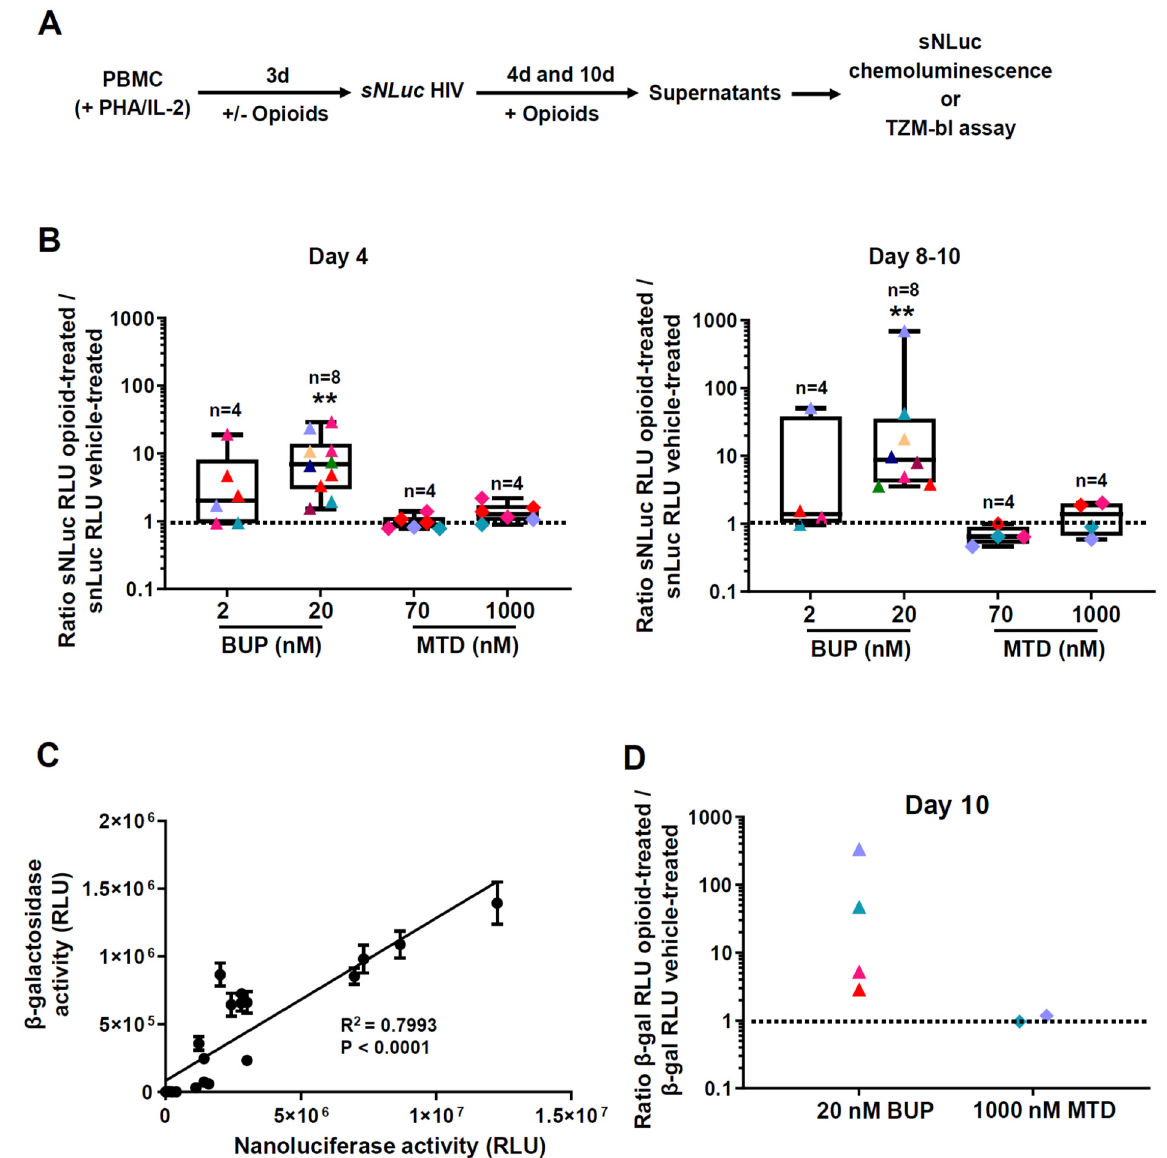
Figure 4. Comparison of methadone and buprenorphine on HIV-1 propagation in longer-term PBMC cultures. ( A ) Experi- mental approach to assess in vitro HIV-1 infection and replication. PBMC were incubated with opioids for 72 h, infected and washed, then the opioid drugs were added back to the culture media. Aliquots were taken at the indicated timepoints, and HIV-1 replication was measured by quantifying nanoluciferase activity in the supernatants, and by infecting Tzm-bl cells and measuring β -gal activity. Chemiluminescence signals were quantified using a luminometer. ( B ) Summary plots showing the effect of the two opioids on nanoluciferase activity measured in supernatants taken at days 4 and 8–10 after HIV-1 infection. The results shown are for a MOI of 0.5. Each donor is represented by a different color; buprenorphine (BUP) and methadone (MTD) treatments are represented by triangles and rhomboids, respectively. The number of different donors per treatment is indicated with an “ n ” above the plots. We did between 4 and 12 technical replicates per condition. X -axis indicates different treatments and concentrations. Y -axis shows the ratio of luciferase activity measured in opioid-treated cultures over luciferase measured in vehicle-treated cultures. Plots indicate median (vertical lines in the middle), interquartile range (boxes), and min to max range (whiskers). p -values were two-tailed and calculated using the Wilcoxon Signed Rank Test, comparing the median obtained in each treatment with a theoretical median value of 1. **: p < 0.01. ( C ) Correlation between nanoluciferase and beta-galactosidase ( β -gal) enzymatic activities. PBMC from two differ- ent donors were infected with 0.5 MOI sNLuc HIV-1. Supernatants were collected on day 10 after infection. Nanoluciferase activity ( x -axis) was determined in a 20 µL fraction of the sample (total = 23 determinations). In parallel, TZM-bl cells were infected with a 1:500 dilution of another aliquot of the same samples. Infections were done using five technical replicates.